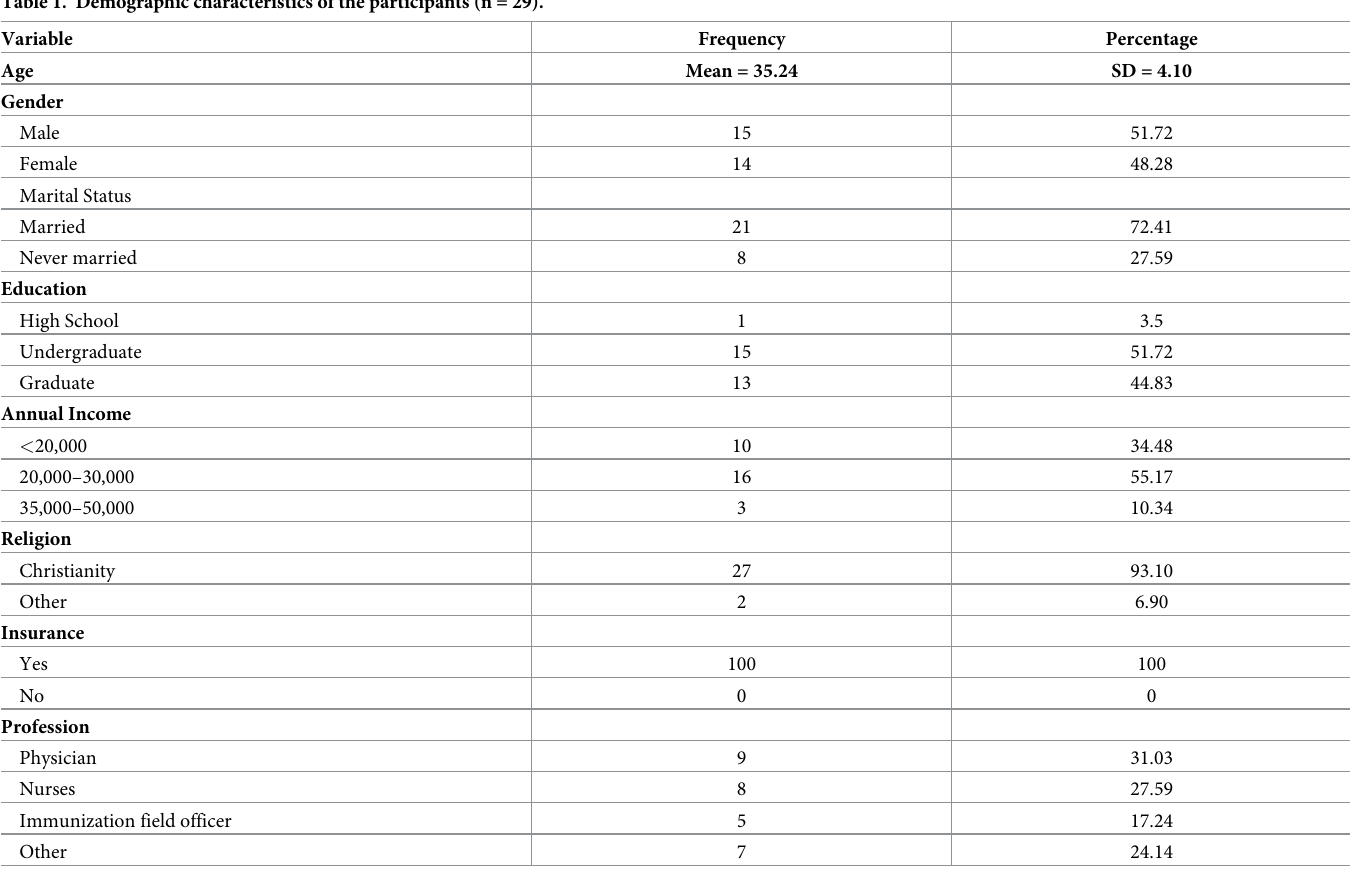
Table 1. Demographic characteristics of the participants (n =